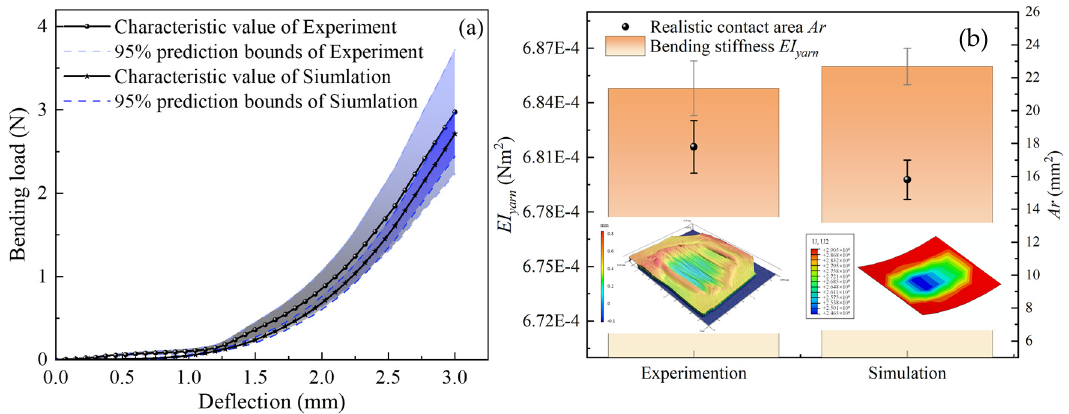
Figure 6. Comparison of experimental and simulation results of yarn bending behavior: ( a ) bending load–deflection curve, ( b ) resulting values of EI yarn and Ar (taking carbon fiber yarn as an example).